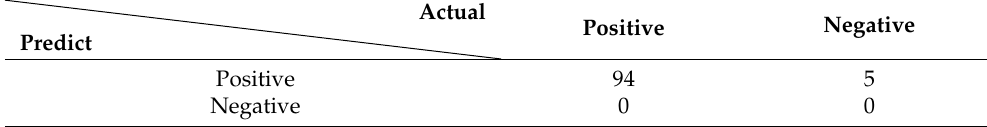
Table 3. The confusion matrix obtained according to PDTN pickup results.